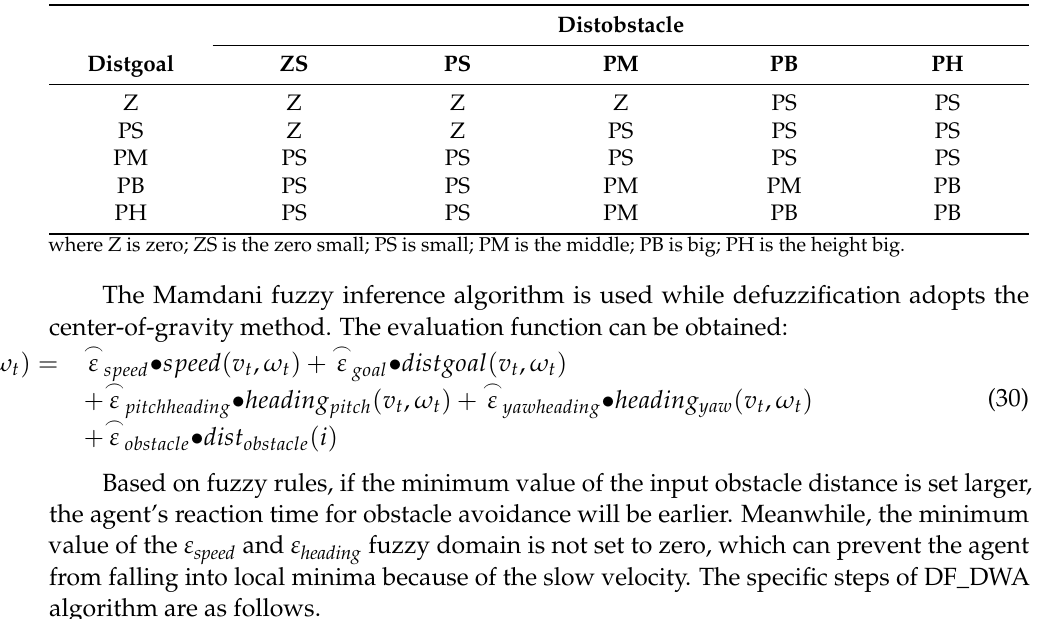
Table 5. Fuzzy control rules of Distgoal, Distobstacle, and ε yawheading